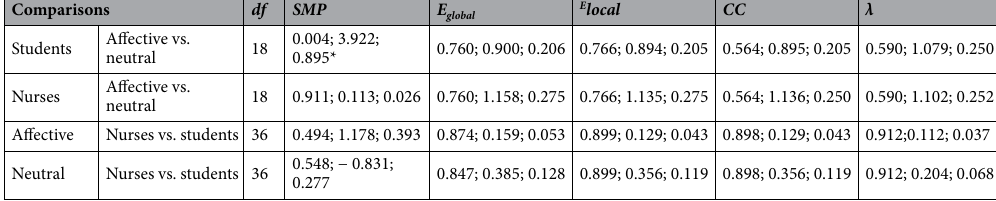
Table 1. Pairwise comparison between parameters in semi-metric analysis and graph theory analysis at global level. The table are shown in (FDR-adjusted p -values; t -values; Cohen’s d ). df indicates degrees of freedom. * represents FDR-adjusted p < 0 .